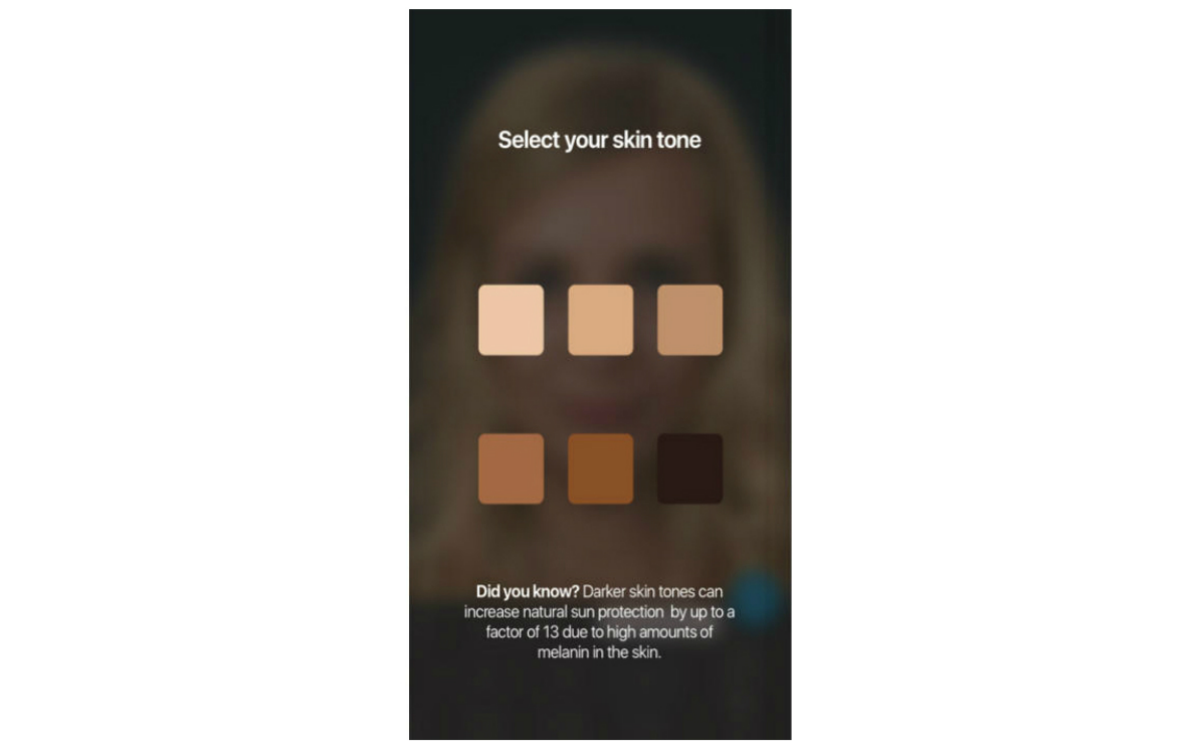
Figure 5. Start screen of the app prompts users to pick their skin